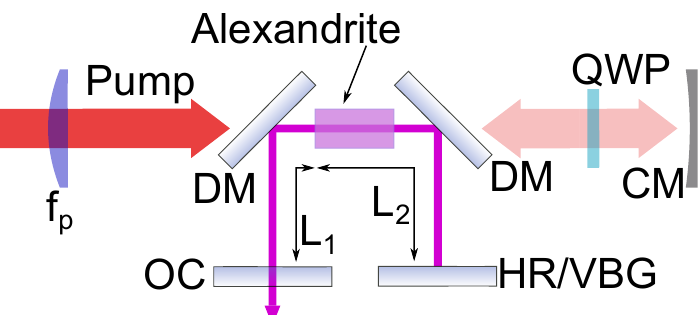
Figure 1. Four-mirror plane-plane cavity with double-pass end-pumping. A four-mirror cavity was formed of: two dichroic mirrors (DM) that were highly transmissive (HT) at the pump wavelength and highly reflective at the laser wavelength ( λ l = 700–820 nm) at 45 ◦ ; a mirror that was highly reflective at the laser wavelength at 0 ◦ (HR); and an output coupler (OC) with reflectivity R OC . The HR mirror was later replaced by the volume Bragg grating (VBG). The cavity lengths L 1 = 35 mm and L 2 = 40 mm were set to provide a laser mode size of ∼ 200 µ m at the crystal for around 20 W of pumping based on the thermal lens modelling